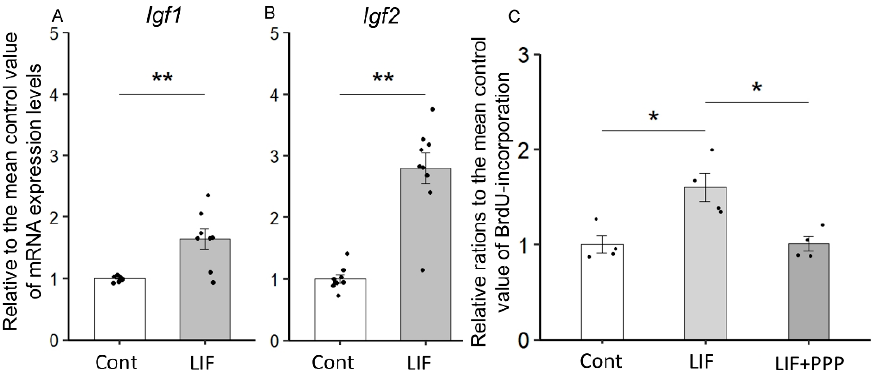
Figure 8. Induction of Igf1 and Igf2 mRNA by LIF and inhibition of LIF-induced proliferation in neural progenitor cells (NPCs) with IGF-1R inhibitor: ( A , B ) quantitative RT-PCR analysis showed that LIF supplementation in culture media increased Igf1 and Igf2 mRNA in NPCs. Igf1: n = 8 per group, Igf2: n = 9 per group. ( C ) LIF-induced proliferation was assessed with a 5-Bromo-2 (cid:48) -deoxyuridine (BrdU)-incorporation assay and revealed that the increase in LIF-dependent BrdU incorporation was inhibited by the addition of picropodophyllin (PPP), an inhibitor of IGF-1R. Data are presented as relative ratios to the mean value of the control (Cont). Each group has four samples. LIF vs. Cont, p < 0.05; LIF vs. LIF + PPP p < 0.05. Statistical analysis was performed with the Kruskal–Wallis test followed by Mann–Whitney U test. Error bars: SEM. * p < 0.05, ** p <